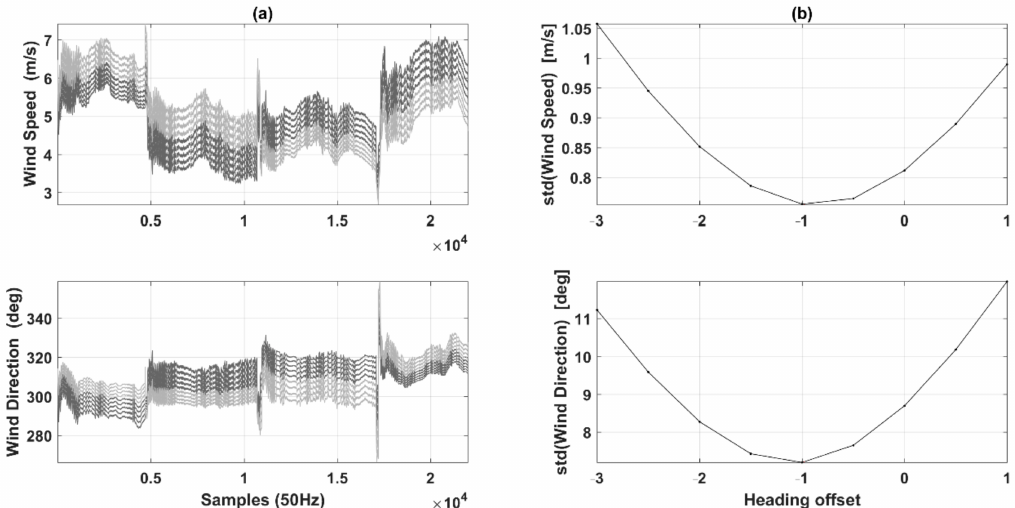
Figure 10. Results of determining the offset value of the heading angle ( ε ψ ) by finding the offset in the heading angle ( ε ψ ) with minimum variances for horizontal wind direction ( top ) and for wind speed ( bottom ) using data from box maneuver. ( a ) The influence of ε ψ on wind speed ( top ) and wind direction ( bottom ). ( b ) The change in variance in wind speed ( top ) and wind direction ( bottom ) within the defined possible